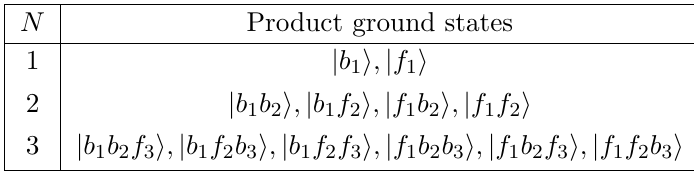
Table 8 . Product ground